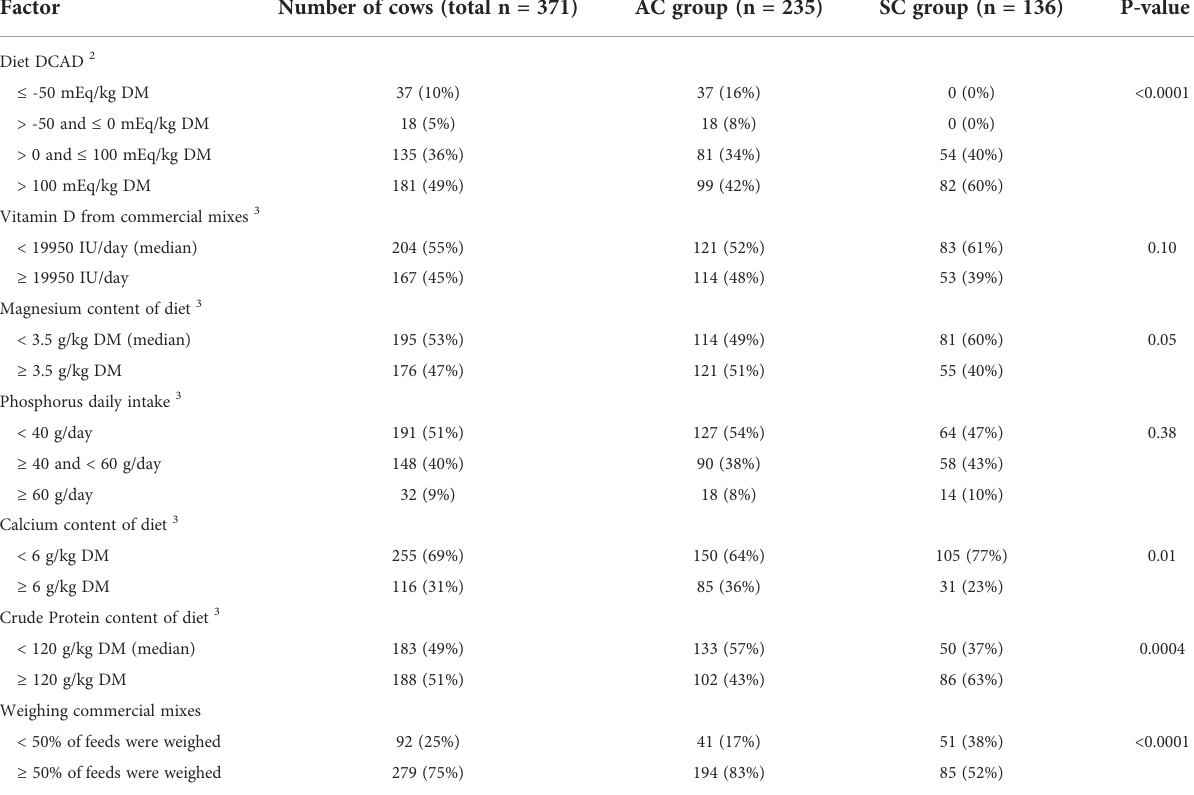
TABLE 3 Description of cow-level variables related to element amounts and tested for inclusion in the subclinical hypocalcemia (SHC) and subclinical hypophosphatemia (SHP) models. Variables were measured as part of a cohort study of 371 dairy cows. Factor